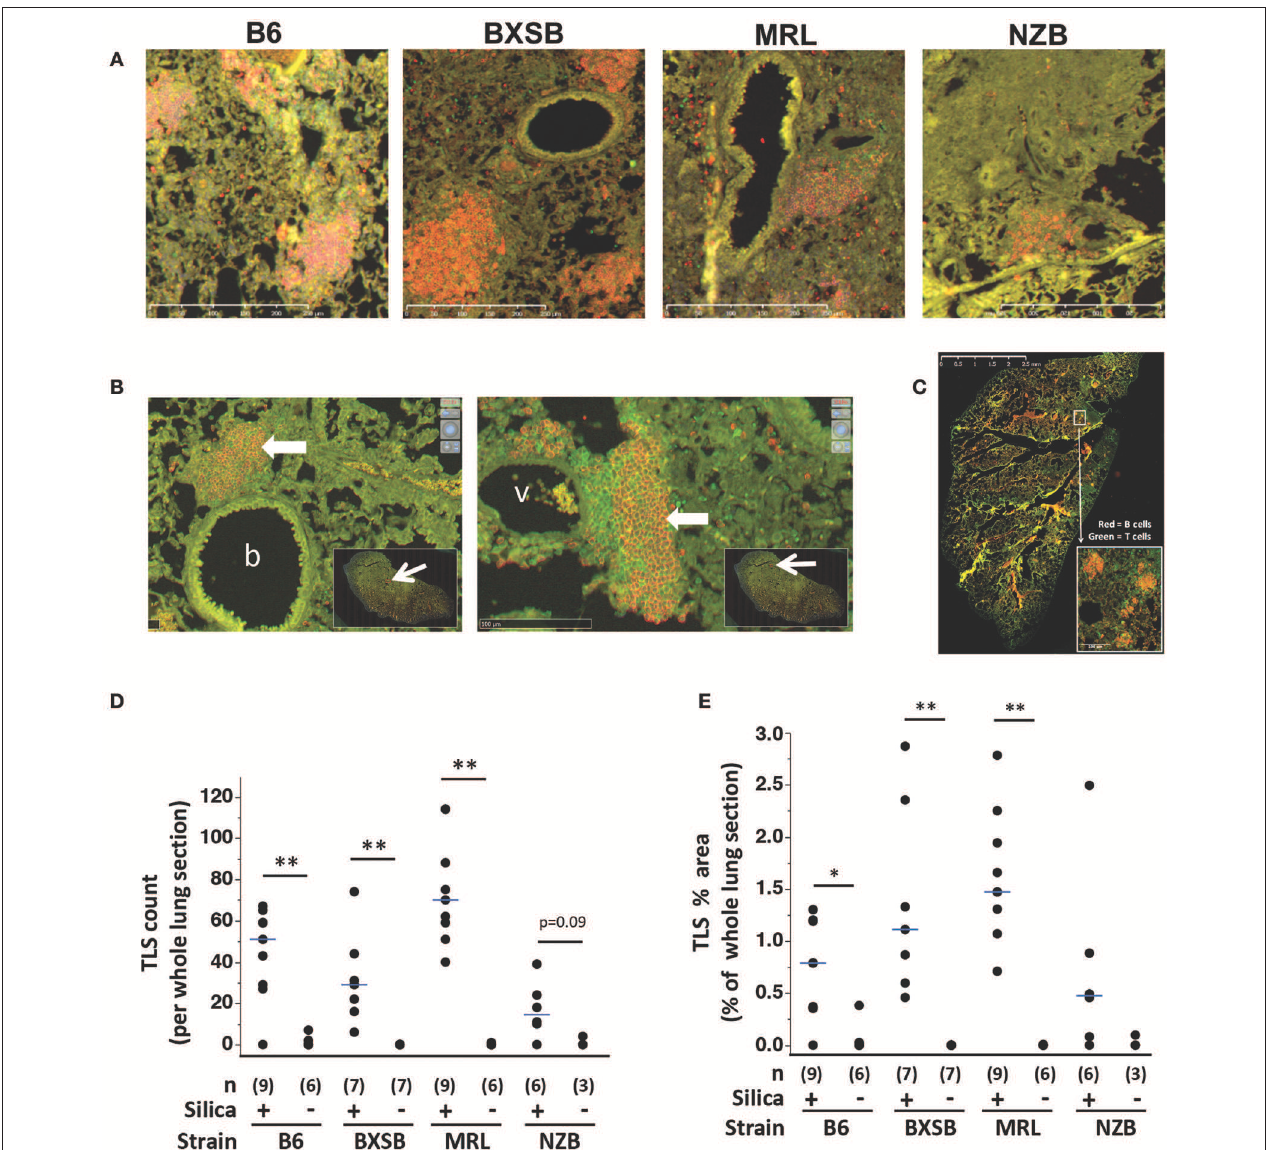
FIGURE 2 | Tertiary lymphoid structures (TLS) in lungs of wildtype mice exposed to silica. (A) Representative sections of lung from mice of indicated strain 2 months (MRL) or 3 months (B6, BXSB, NZB) after instillation of silica or vehicle, stained with anti-B220 (B cells, red) and anti-CD3e (T cells, green), original magnification × 100. (B) Representative peribronchiolar (left) and perivascular (right) tertiary lymphoid structures (thick arrows), from the lung of an MRL mouse 1 month after silica exposure; b, bronchiole; v, vessel. The insets show the whole lung section, with the area of magnification outlined by the red box at the tip of the arrow. (C) Representative whole lung section scanned after staining with fluorescein-conjugated anti-mouse-CD19 (B cells, red) or anti-mouse-CD3e (T cells, green). The inset shows four TLS. TLS were counted and TLS area quantitated across the entire lung section. (D) TLS number per whole lung section; and (E) TLS area as percentage of area of whole lung section. For scatterplots each symbol represents an individual mouse; the median for each group is indicated by the bar; * p < 0.05 and ** p < 0.01 for silica- vs. vehicle-exposed mice of same strain, Wilcoxon rank sum test.